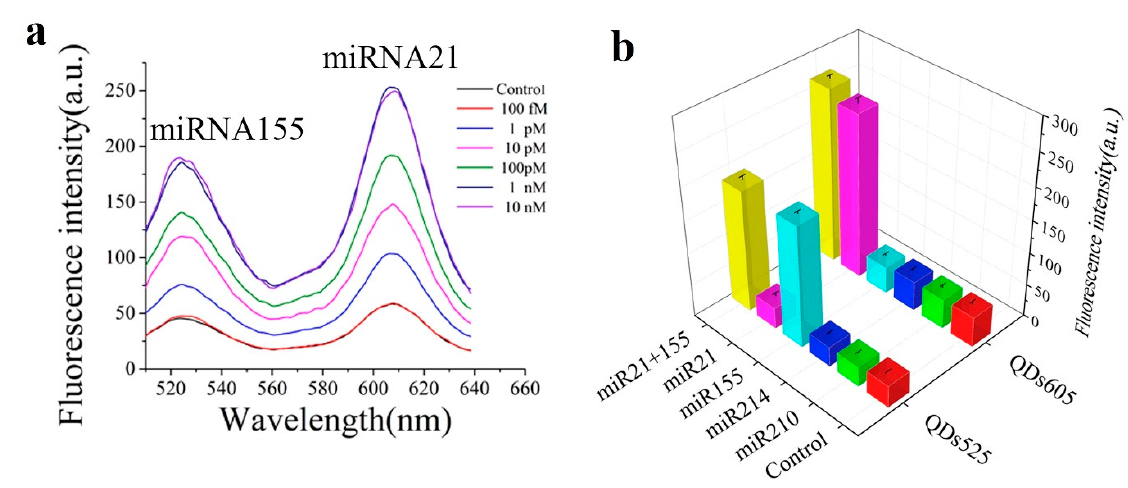
Figure 7. ( a ) Fluorescence spectra of samples with different concentrations of miR-21 and miR-155 (control represents the sample without any miRNA) ( b ) Specificity assay with no miRNA (Control), miR-210-3p (indicated as miR-210) and miR-214 (concentration 100 pM). ( a , b ) Reprinted [55], Copyright 2017, with permission from